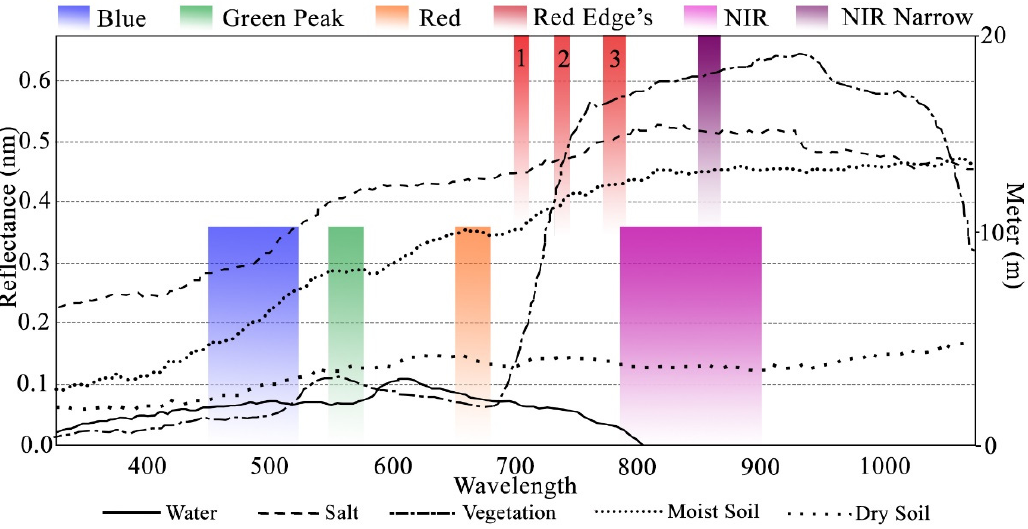
Figure 4. Spectral curves of the salt lake components from ASD, and spatial resolution of each of the spectral bands used from Sentinel-2.